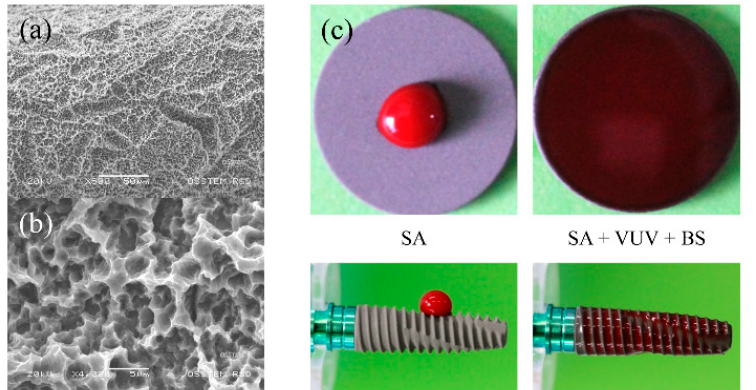
Figure 1. Morphologic observation of a sand-blasted and acid-etched (SA) surface by scanning electron microscope (SEM) at × 500 ( a ) and × 4000 magnification ( b ); ( c ) Comparison of contact angles of defibrinated sheep blood on titanium discs and implant fixtures, respectively. SA, a conventional SA surface; SA + VUV + BS, an SA surface coated with a pH-buffering agent after vacuum-UV treatment.